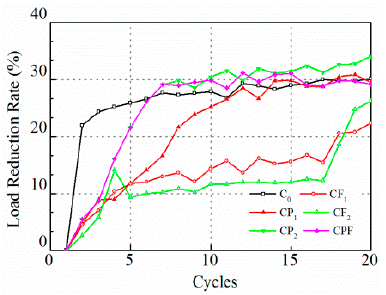
Figure 12. Load reduction rate at 0.1 mm crack opening for the first 20 runs.